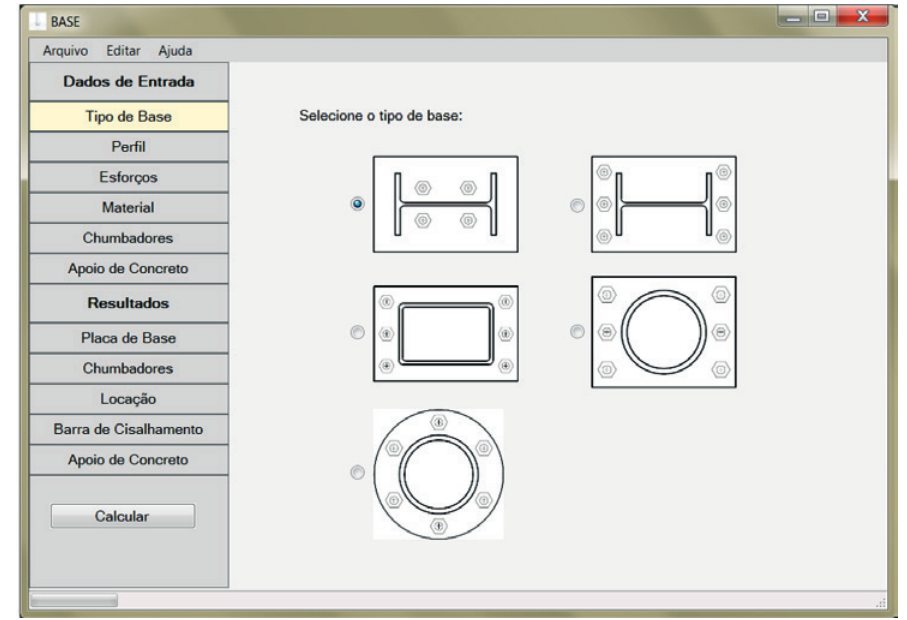
Janela de dados de entrada de escolha do tipo de